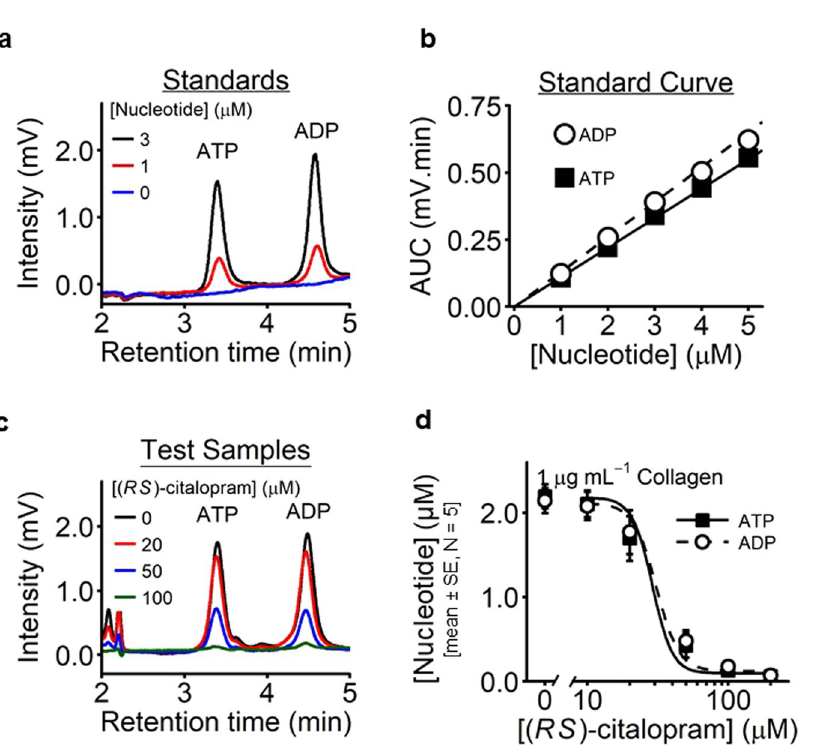
Figure 4. Inhibition by citalopram of collagen-induced release of ATP and ADP from platelets. WP were stimulated with collagen (1 μ g mL − 1 ) for 6 min under aggregometry conditions (37 °C, 1,000 rpm), supernatants collected, and levels of ATP and ADP quantified using HPLC and absorbance detection at 254 nm (N = 5 blood donors). ( a ) Example HPLC chromatograms, showing known ATP and ADP peaks. ( b ) Peak AUC was plotted against nucleotide concentration to generate standard curves. ( c ) Example HPLC chromatograms from supernatants of collagen-stimulated platelets pre-incubated with ( RS )-citalopram. ( d ) Concentration-inhibition curves for ( RS )-citalopram (0–200 µ